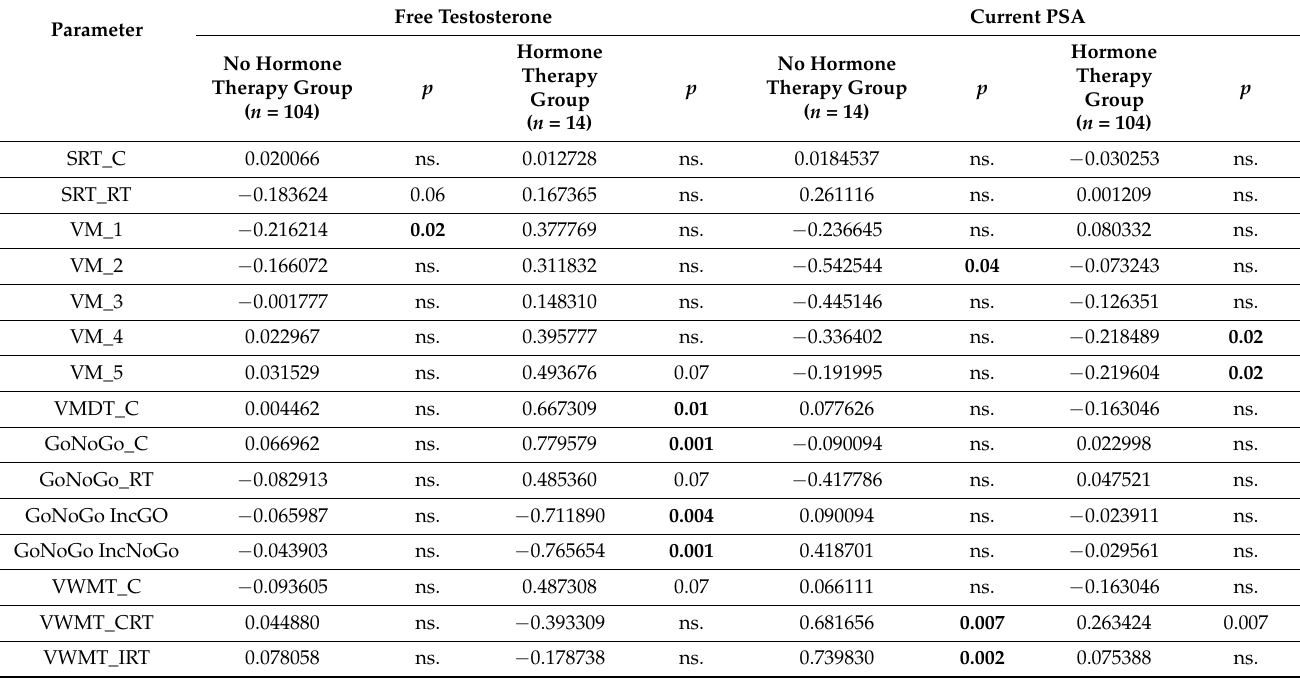
Table 5. R-Spearman correlations of cognitive test and free testosterone in group treated and untreated by hormone therapy.